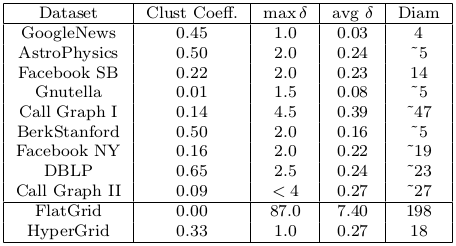
Table from the paper: A Geometric Distance Oracle for Large Real-World Graphs
Table text:
Dataset
Clust Coeﬀ.
maxδ
avg δ
Diam
GoogleNews
0.45
1.0
0.03
4
AstroPhysics
0.50
2.0
0.24
˜5
Facebook SB
0.22
2.0
0.23
14
Gnutella
0.01
1.5
0.08
˜5
Call Graph I
0.14
4.5
0.39
˜47
BerkStanford
0.50
2.0
0.16
˜5
Facebook NY
0.16
2.0
0.22
˜19
DBLP
0.65
2.5
0.24
˜23
Call Graph II
0.09
<4
0.27
˜27
FlatGrid
0.00
87.0
7.40
198
HyperGrid
0.33
1.0
0.27
18